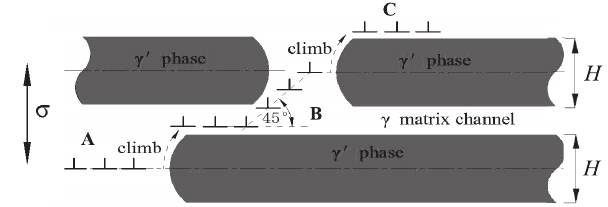
Fig. 10: Schematic diagram of the dislocations slipping and climbing over the rafted g′